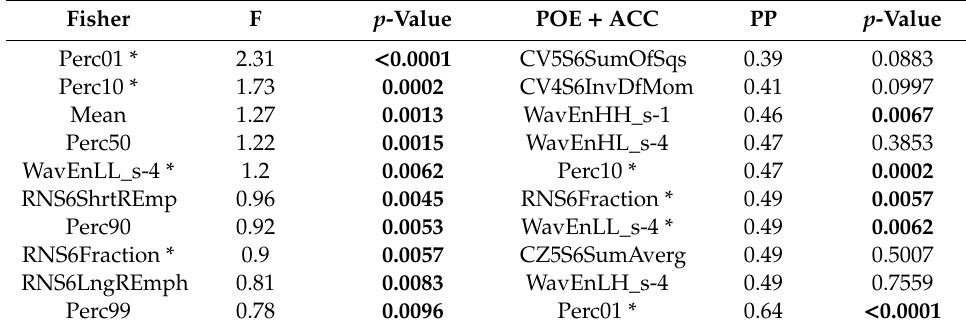
Table 1. Sets of features generated by each selection method and the univariate analysis results following the comparison of high-grade gliomas with brain metastases.